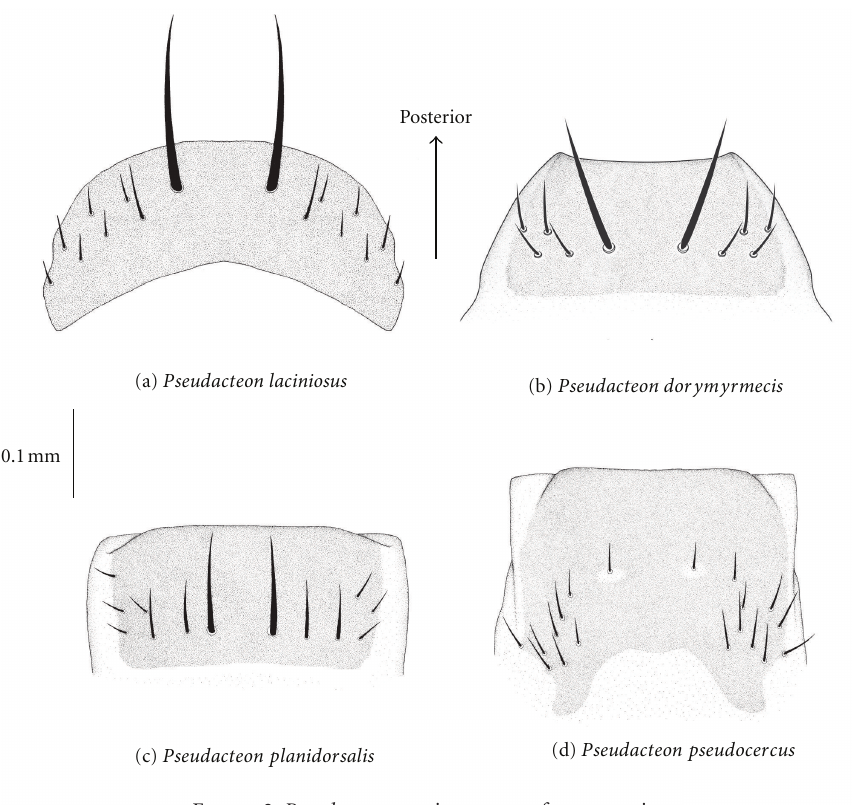
Figure 2: Pseudacteon species, venter of segment